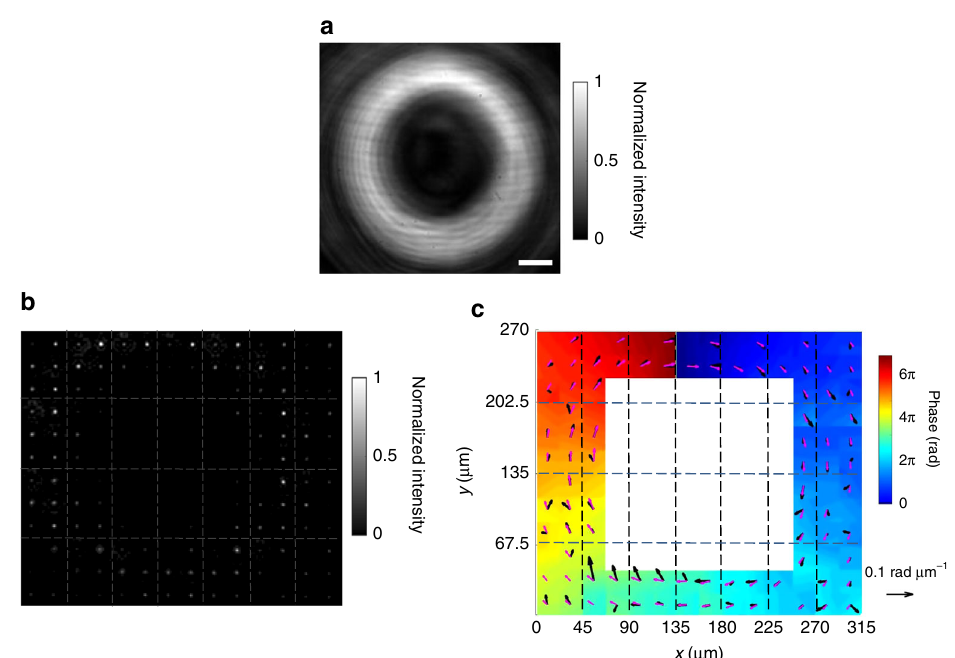
Fig. 6 Pro fi ling of a vortex beam by the metalens array. a Intensity pro fi le for a vortex beam without the metalens array. Scale bar: 50 μ m. b Raw data of measured focal spots of the metalens array. c Phase gradients (black arrows for the measured, pink arrows for the calculated) and wavefront (false-color scale) reconstructed on this basis. The dashed lines highlight the individual pixels of the 7 × 4 metalens array. The reference arrows has a length